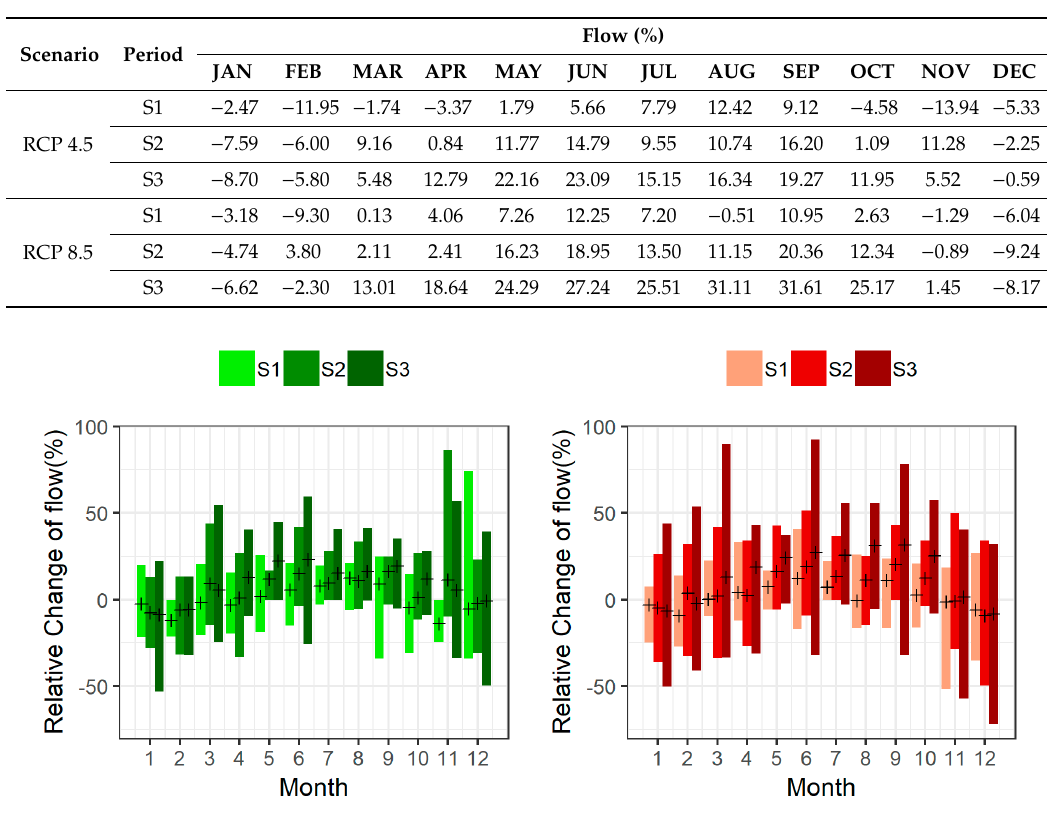
Table 10. Relative change (%) of the 30-year average monthly flow during three future periods for RCP 4.5 and 8.5 in South Korea. The values in this table were calculated by first converting the daily data into monthly data. Next, the relative change of the 30-year average monthly flow for 13 GCMs was calculated for each period, and the average of the relative change for 13 GCMs was determined.